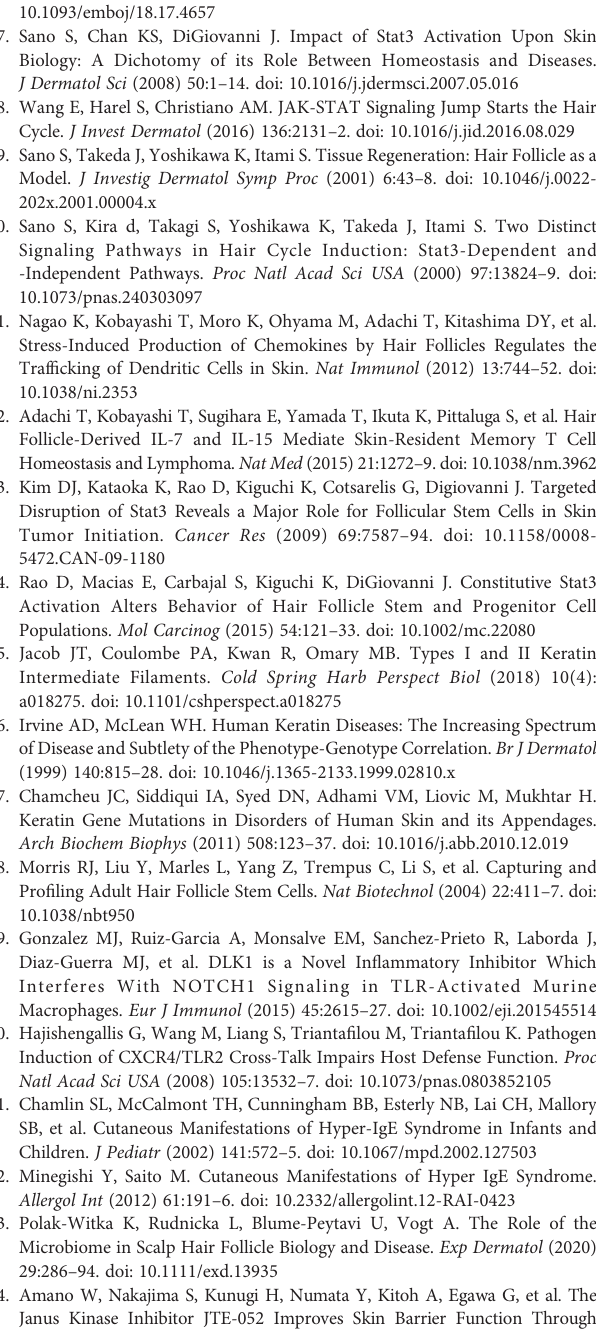
µm 2 square fi eld was counted (n=5 to 7) and shown in the dot plot on bottom. Bars indicates mean. **p<0.01. Supplementary Figure 2 | Role of STAT3 signalingin maintaininghomeostasis of skin keratinocytes. A schematic diagram shows that STAT3 signaling is required for balancing type I and II Keratin genes expression disturbed by microorganisms to maintain skin homeostasis. Supplementary Table 1 | List of primer sets for RT-q-PCR